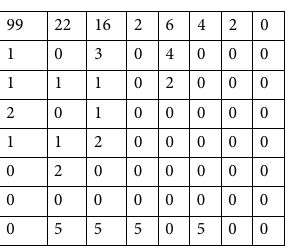
Table 2. Coefficient of airport image after performing DCT and 8 quantization